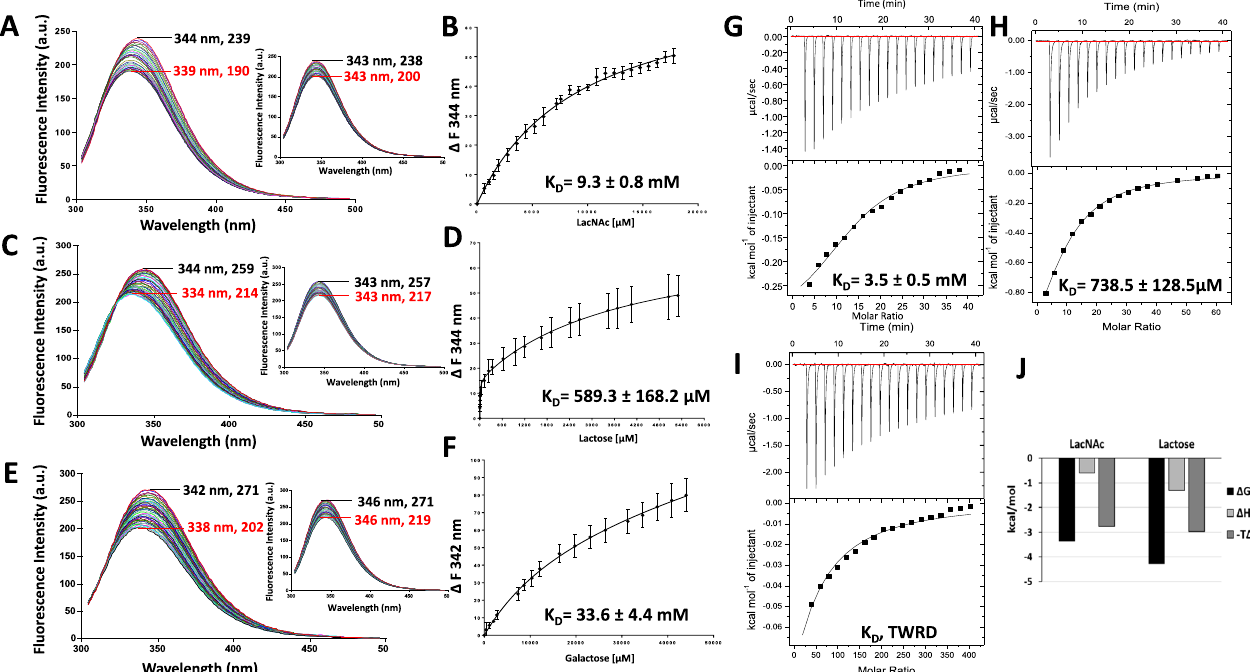
Figure 5. Determination of galectin-4-ligand interactions by TFS and ITC. Galectin-4 (5 µ M) florescence intensity with increased concentrations of LacNAc ( A ), lactose ( C ) and galactose ( E ) were recorded by fluorescence spectroscopy. Numbers indicate the maximum fluorescence wavelength and corresponding fluorescence intensity for the first (no ligand/buffer titration, black) and last (red) titration traces. Inserts in each figure show buffer control titrations. Ligand concentrations vs changes in fluorescence intensity were plotted and analysed using One site- Specific binding model to obtain the binding affinities to LacNAc ( B ), lactose ( D ) and galactose ( F ). Heat changes for titration of galectin-4 (100 µ M) with 10 mM LacNAc ( G ), 30 mM lactose ( H ) and 200 mM galactose ( I ) were measured by ITC (upper panels) with data fit to One set of sites interaction model (bottom panels). Data were plotted as means ± SEM from three independent experiments for each assessment. Panel (J) shows thermodynamic profiles with enthalpy ( ∆ H), entropy ( ∆ S) and Gibbs free energy ( ∆ G) changes associated with galectin-4 binding to LacNAc and